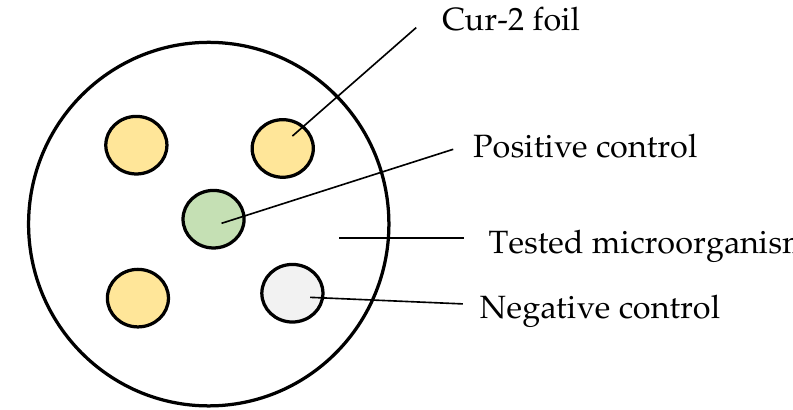
Figure 1. Scheme of the placement of the film discs on nutrients.